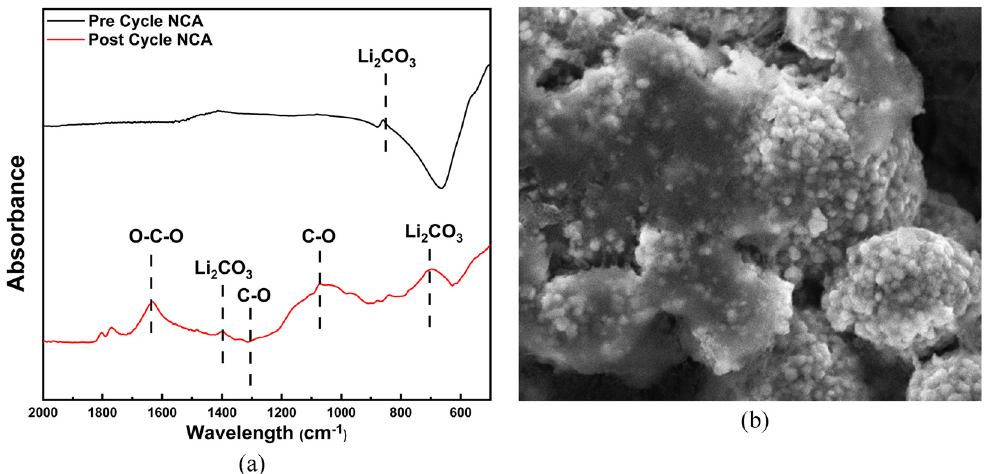
Figure 8: ( a ) FTIR and ( b ) SEM image of post - cycled NCA -